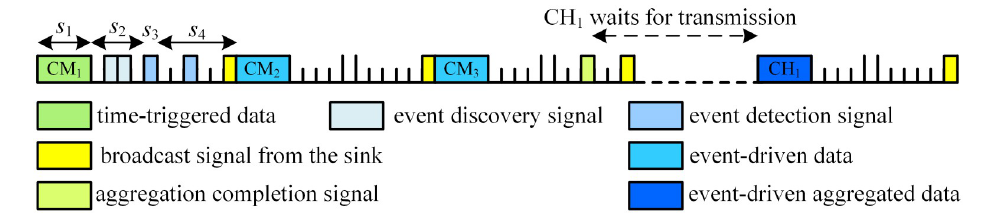
Fig 5. Transmission schedule of serving event-driven